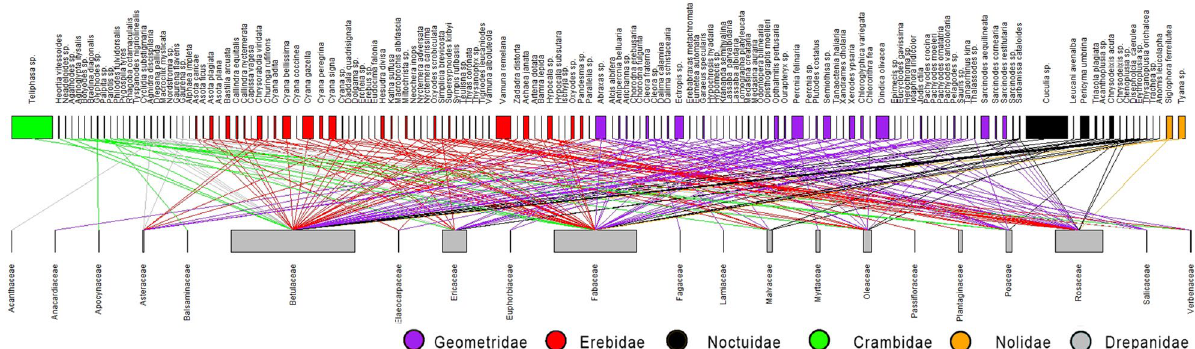
Figure 5. Consolidated settling moth-plant pollen transfer network (width of higher-level boxes indicates number of pollen grain carried by moths whereas width of lower level boxes indicate total pollen grain of a plant family